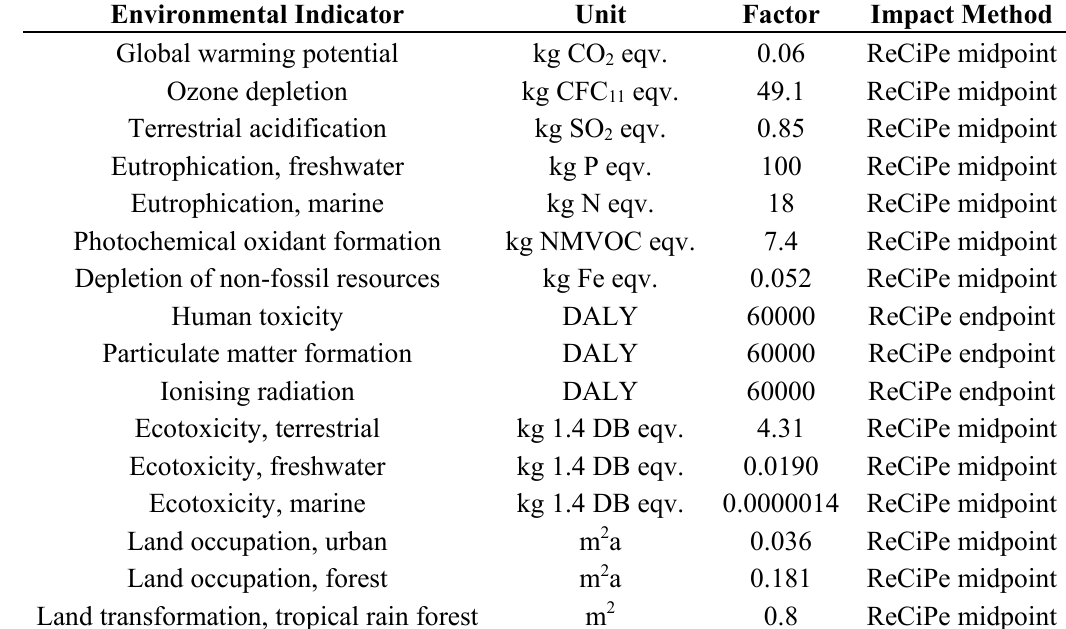
Table 2. The characterisation value of each environmental indicator of a selected impact method is multiplied by a factor, based on [27], in order to allow the comparison of building